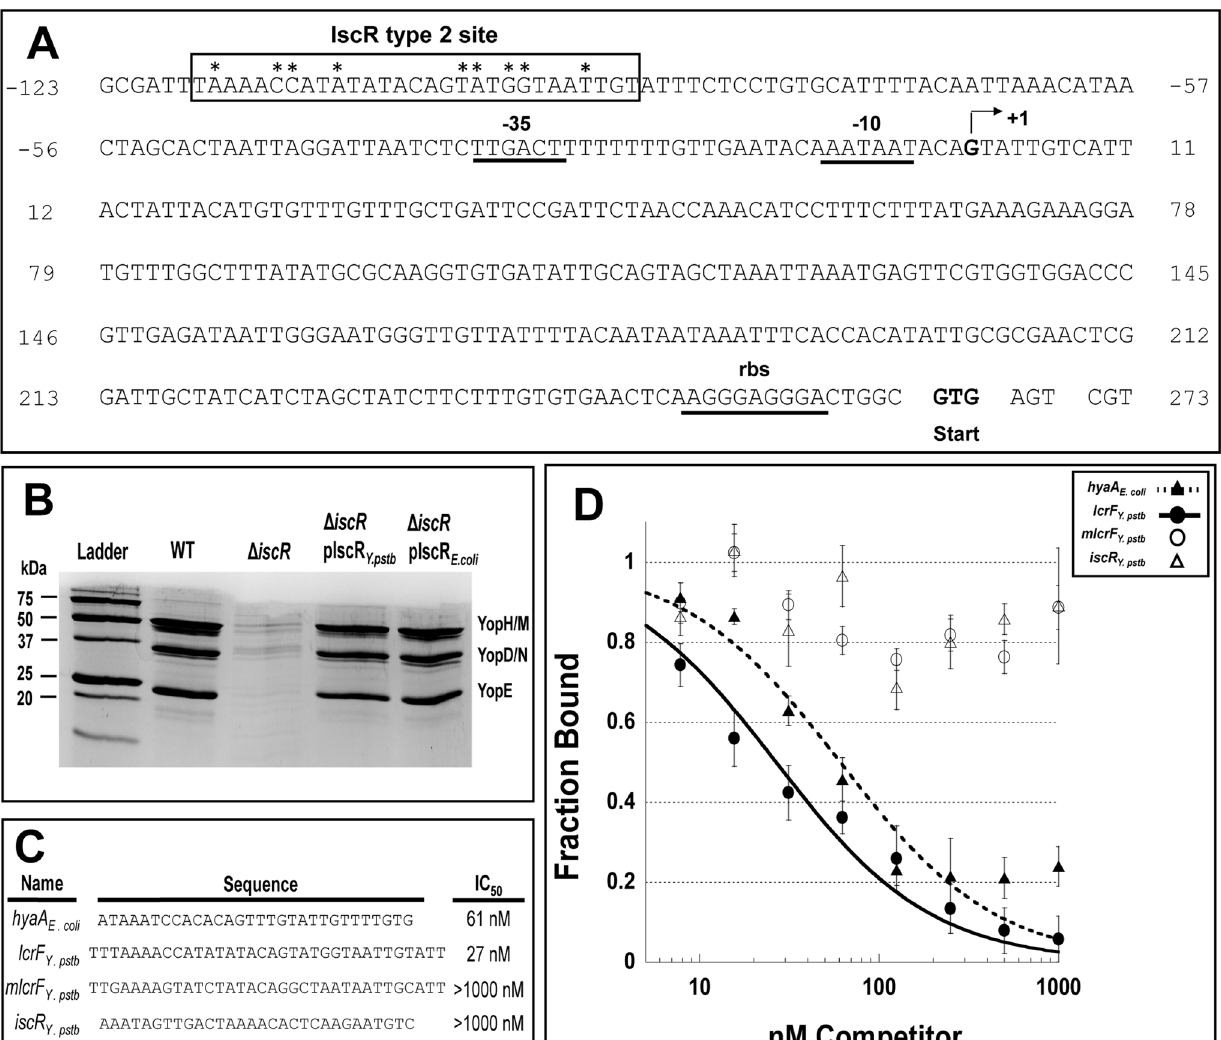
Figure 8. IscR binds a novel motif 2 site within the lcrF promoter region. ( A ) Displayed is the promoter region of the yscW-lcrF operon including 2 35 and 2 10 regions, the transcriptional start site ( + 1) and the ribosome binding site (RBS) [24]. The IscR type 2 DNA-binding site is indicated by a black box. The nine bases previously found to be important for IscR binding are indicated by asterisks [35]. ( B ) Y. pseudotuberculosis IP2666 wild type (WT), iscR deletion ( D iscR ), D iscR complemented with Y. pseudotuberculosis iscR ( D iscR pIscR Y.pstb ), and D iscR complemented with E. coli iscR ( D iscR pIscR E.coli ) strains were grown in 2xYT low calcium media at 37 u C to induce type III secretion in the absence of host cells. Proteins in the bacterial culture supernatant were precipitated and visualized alongside a protein molecular weight marker (Ladder) on a polyacrylamide gel using commassie blue. Sample loading was normalized for OD 600 of each culture. These results are representative of three independent experiments. ( C ) The competitor DNA sequences used for the competition assay and the resulting IC 50 concentrations are displayed. Nucleotides in bold and underlined correspond to those that were changed in the mlcrF sequence and have been found to be important for IscR binding in E. coli [33]. ( D ) Competition assay utilizing 59 nM E. coli apo-locked IscR (IscR-C92A) and 5 nM TAMRA labeled hya DNA [33]. Assay were performed using a range of 8 to 1000 nM unlabeled competitor DNA, including the known E. coli hya site competitor (closed triangles), the in silico identified Y. pseudotuberculosis lcrF site competitor (closed circles), mutated lcrF ( mlcrF ) site competitor (open circles), and the negative control Y. pseudotuberculosis isc in silico identified motif I site competitor (open triangles). Shown are the averages 6 SEM from three independent experiments.